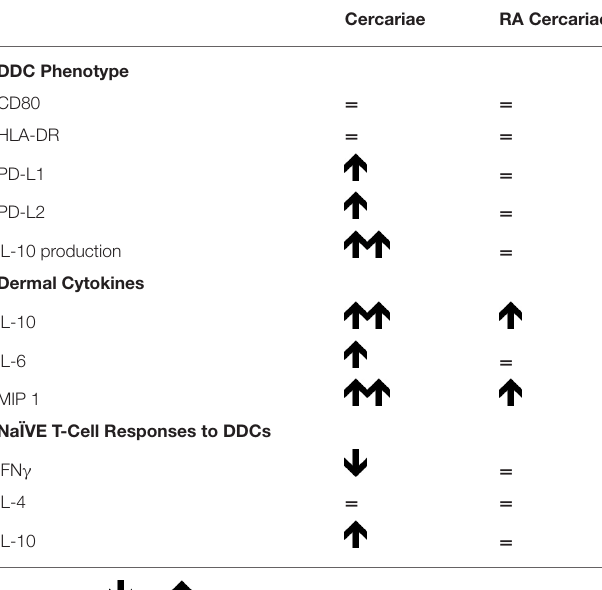
TABLE 2 | Immune phenotype of (RA) cercariae stimulated